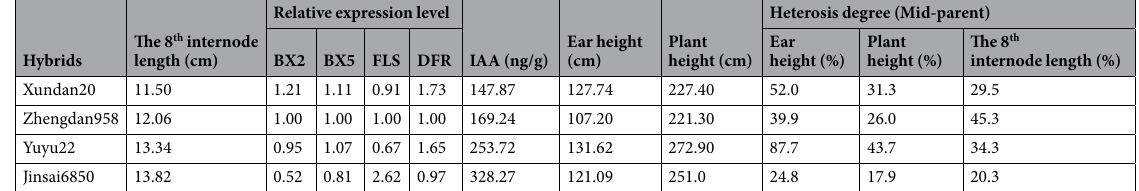
Table 1. Indole-3-acetic acid (IAA) content in hybrids and the relative expression levels of key genes influencing IAA biosynthesis and polar distribution.